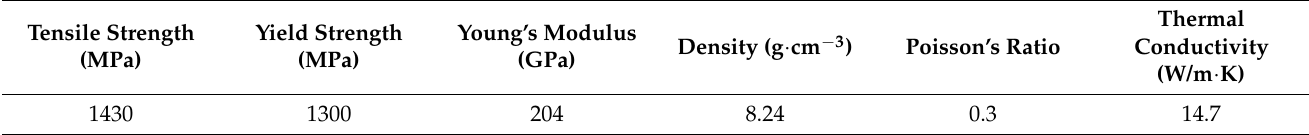
Table 4. Typical mechanical properties at room temperature.